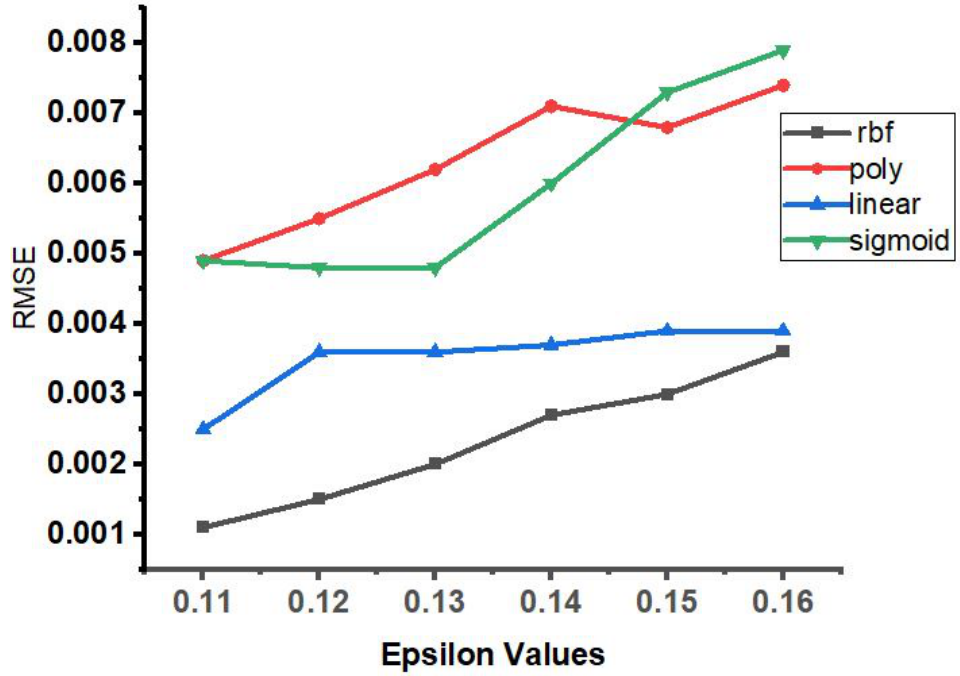
Figure 5. Kernel function comparison for 50%